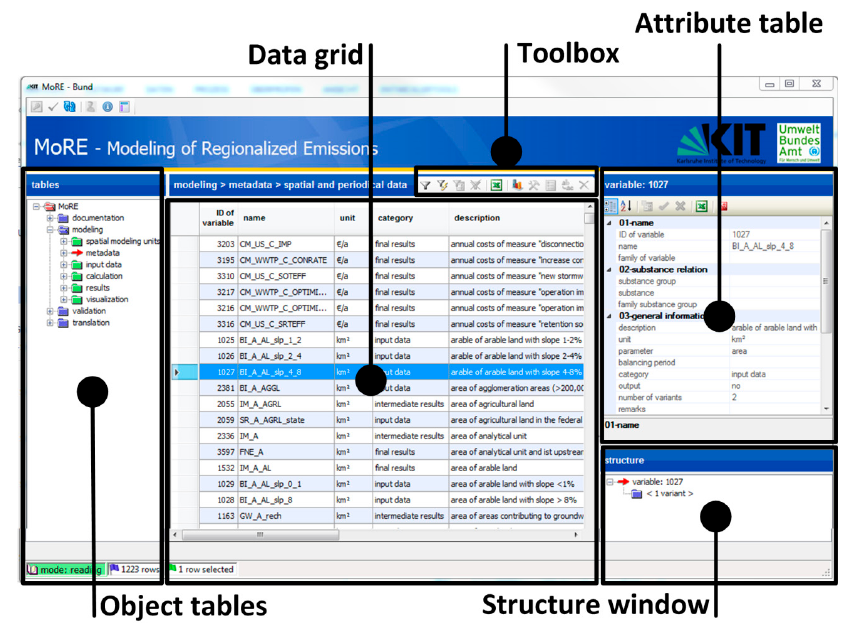
Figure 2. Screenshot of the graphical user interface of MoRE Developer with its five main compartments highlighted.